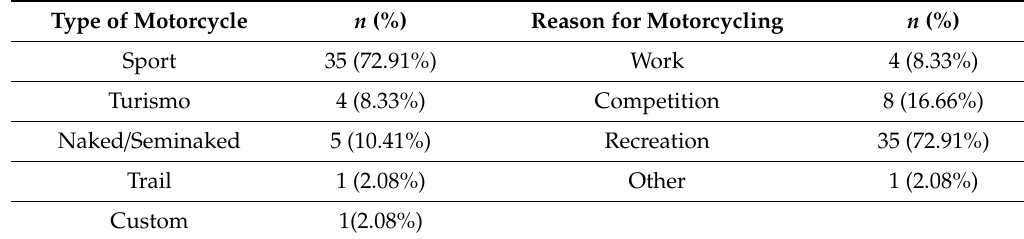
Table 2. Type and reason for motorcycling.